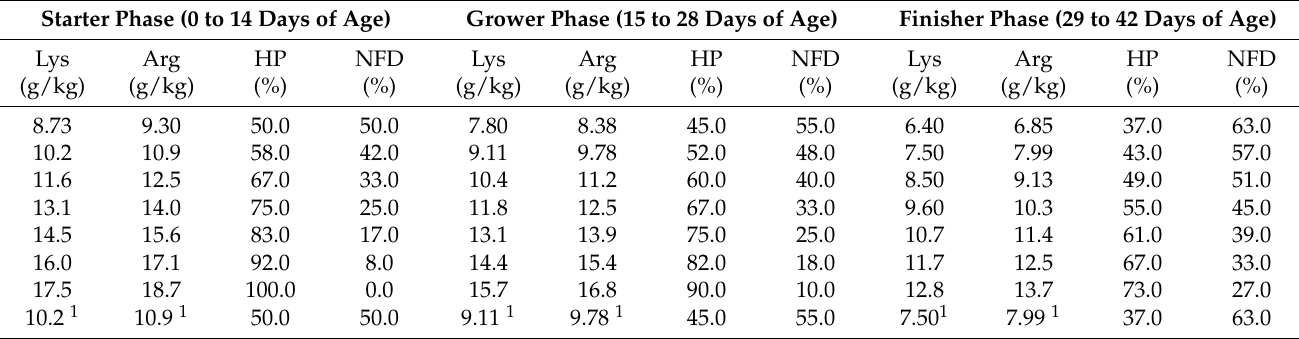
Table 2. Standardized ileal digestible lysine (Lys) and digestible arginine (Arg) concentration obtained from different dilution series between high-protein (HP) and nitrogen-free (NFD) diets used in the starter, grower, and finisher phases. Starter Phase (0 to 14 Days of